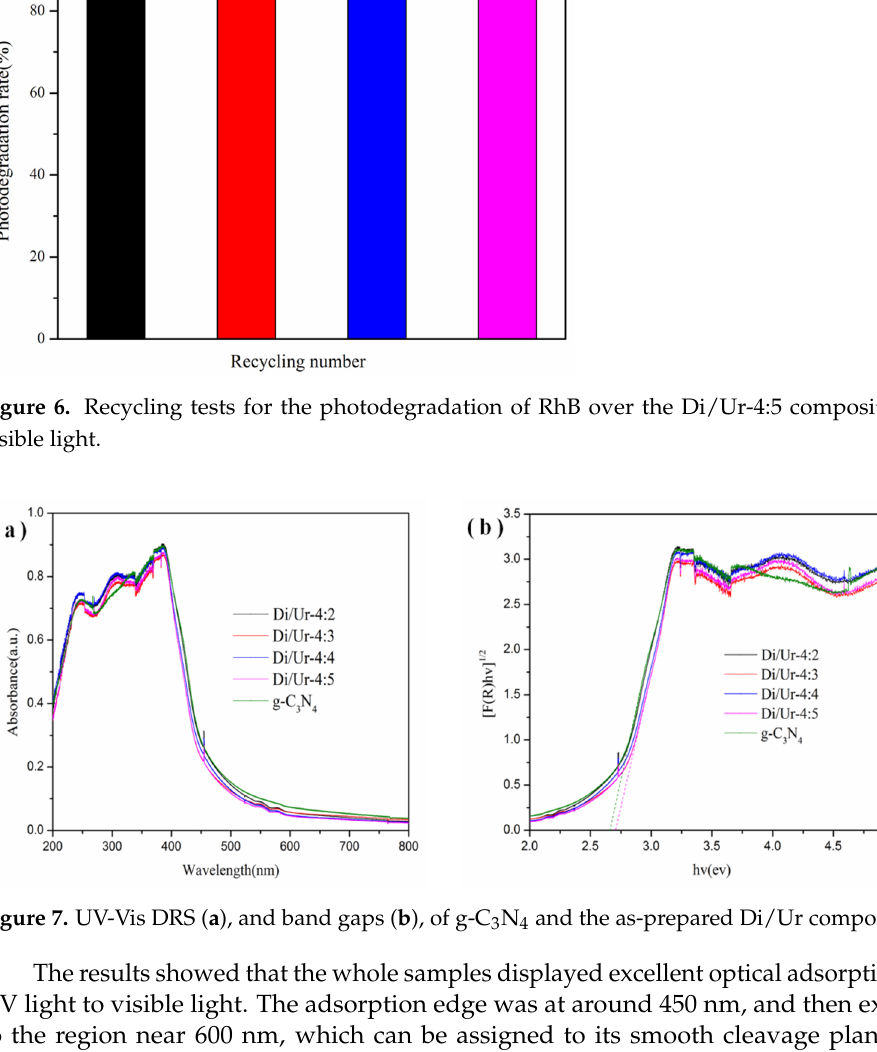
Figure 7. UV-Vis DRS ( a ), and band gaps ( b ), of g-C 3 N 4 and the as-prepared Di/Ur composites.